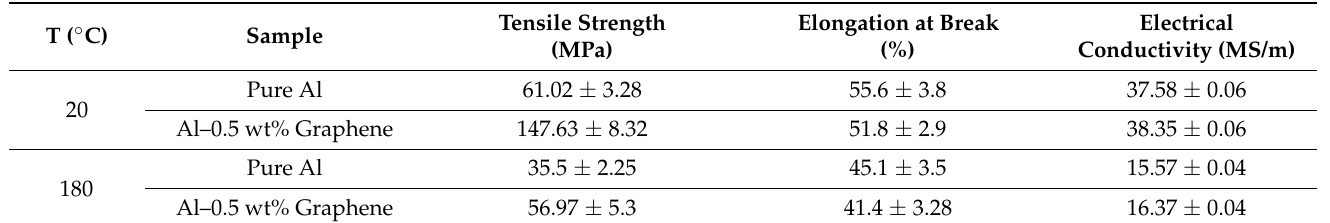
Table 4. Electrical conductivity and mechanical properties of pure Al and Al–0.5% wt GNP composite.